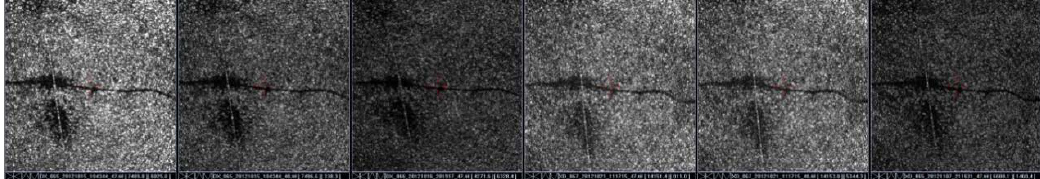
Figure 9. A Image Tie Point on six SAR